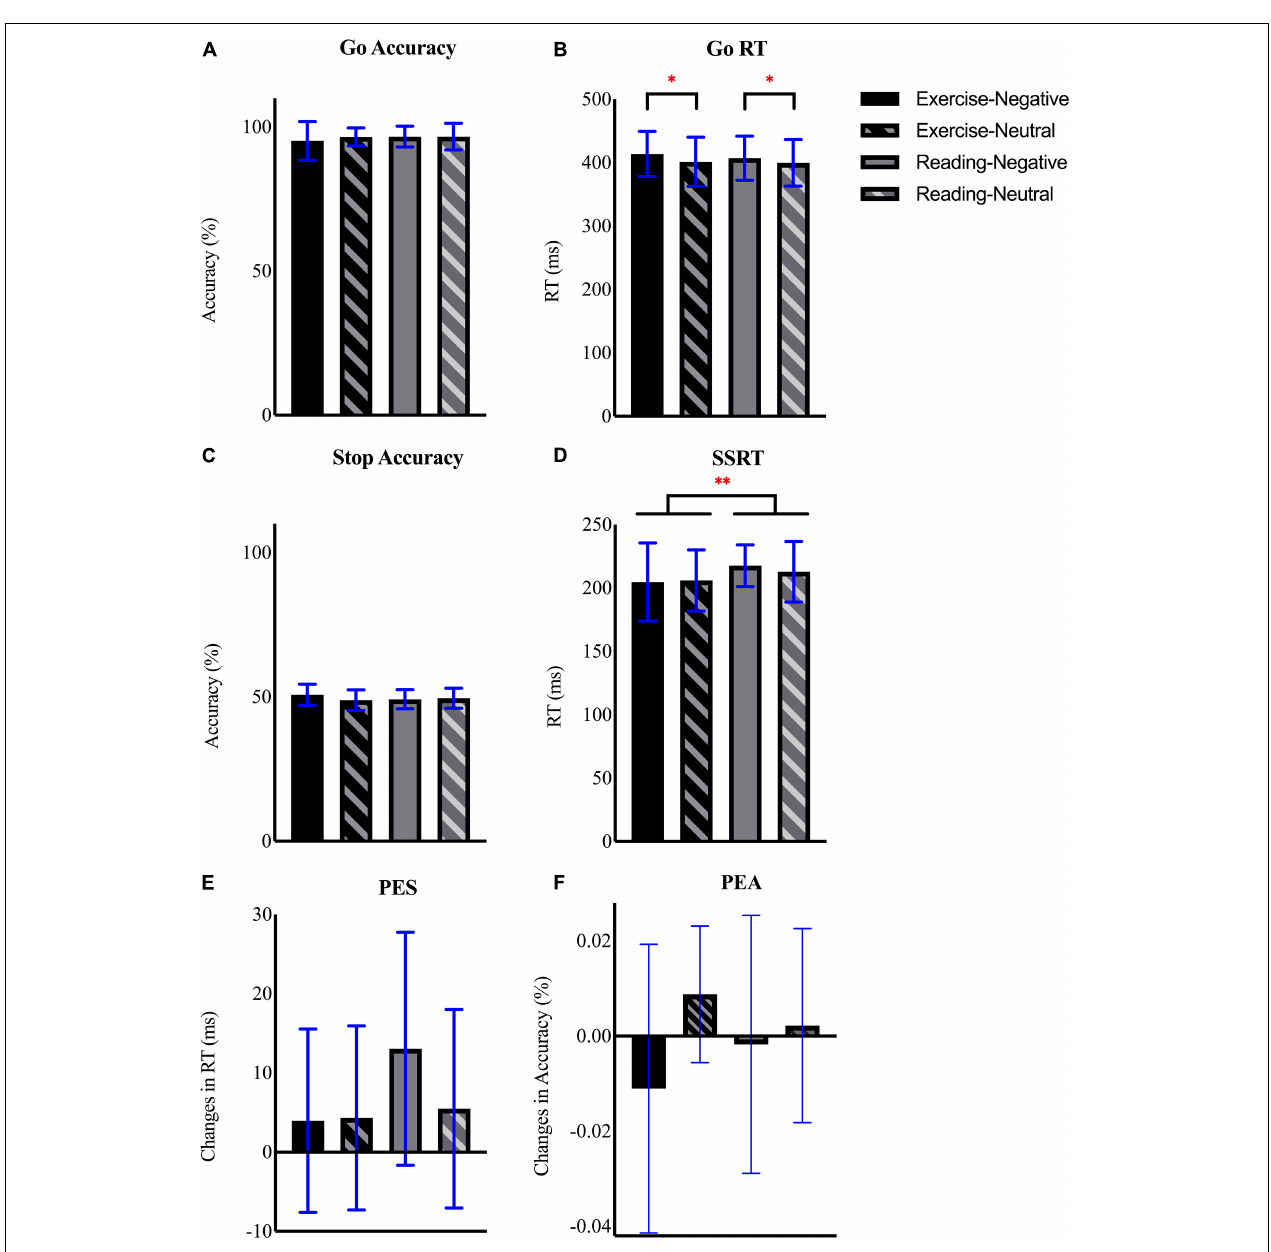
FIGURE 2 | Mean and SD of (A) go accuracy, (B) go reaction time (RT), (C) stop accuracy, (D) stop signal reaction time (SSRT), (E) post-error slowing (PES), and (F) post-error accuracy (PEA) across interventional sessions and emotional conditions. *Refers to p ≤ 0.05, ∗∗ refers to p ≤